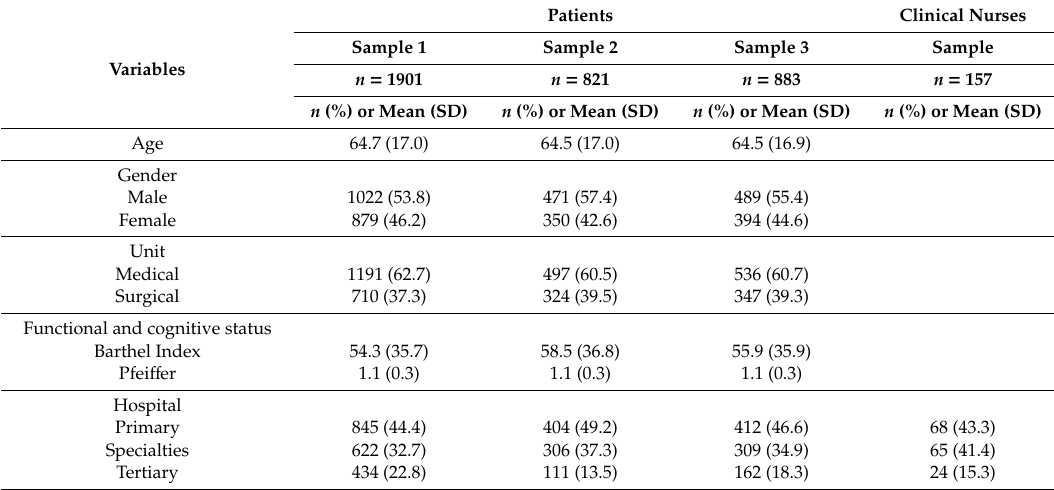
Table 1. Characteristics of the three subsamples.